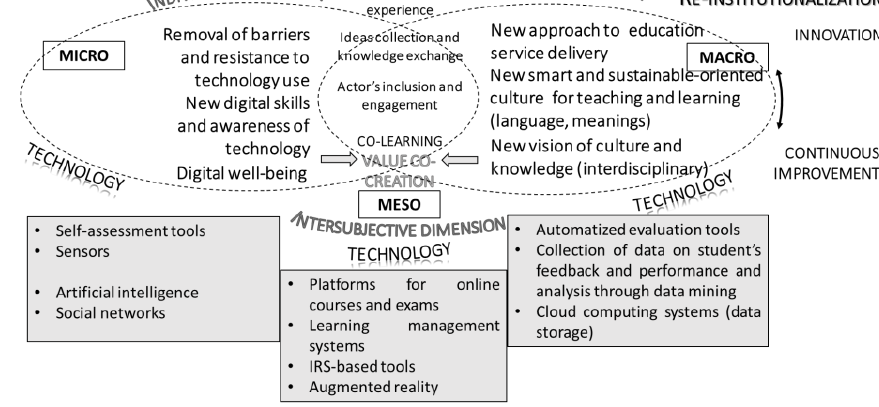
Fig. 2. A conceptual framework for transformation and innovation in education